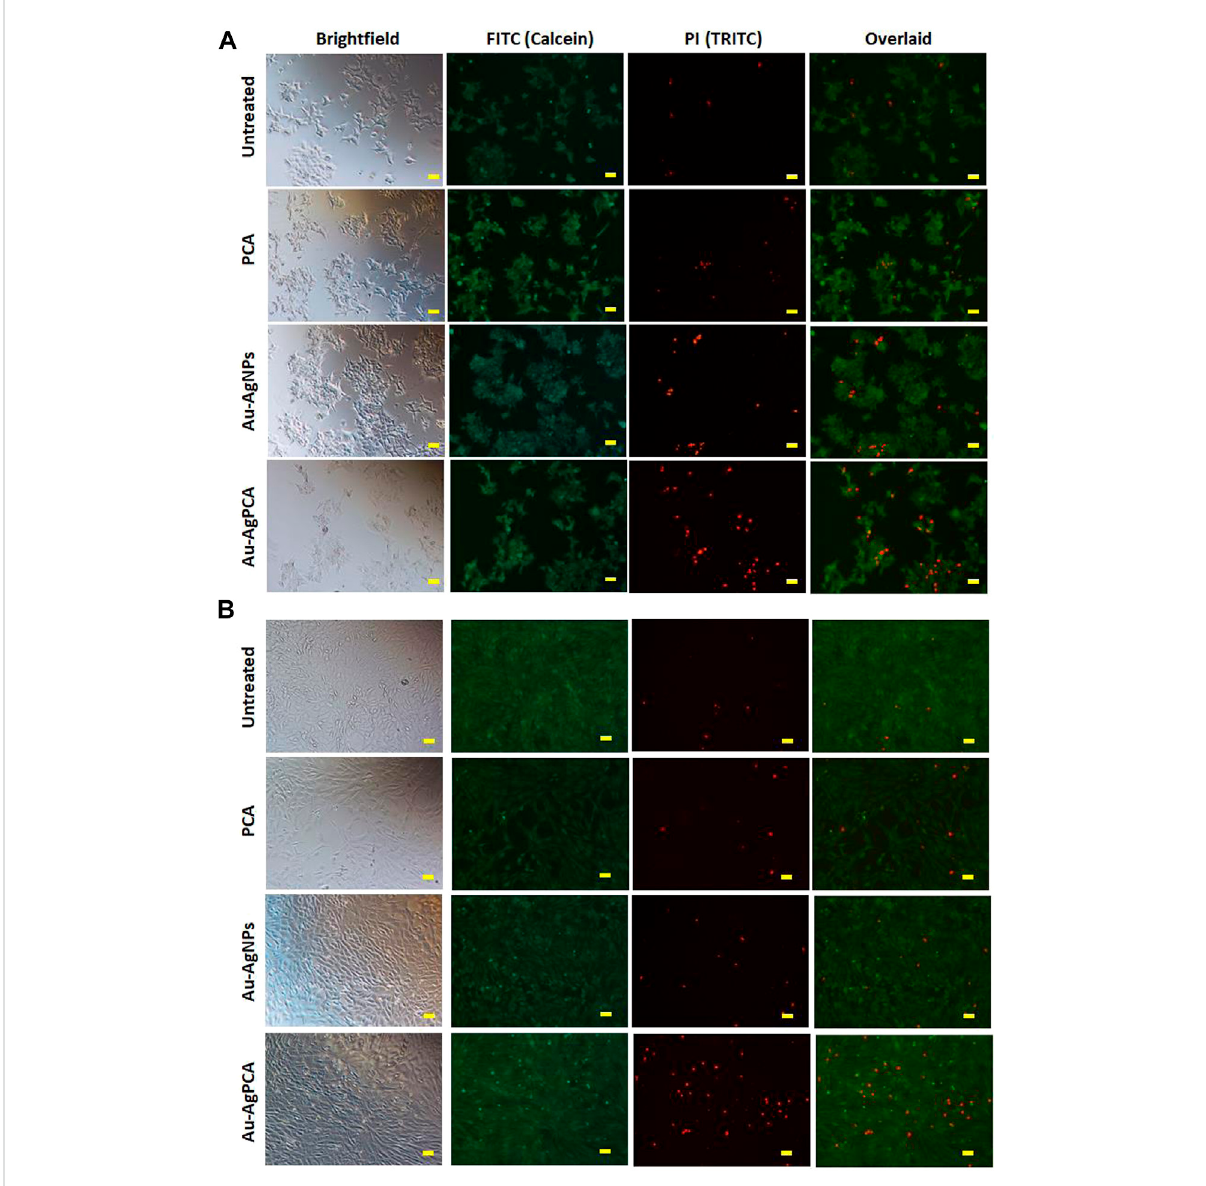
FIGURE 6 Live/dead cells staining. Calcein AM(green: live cells)andpropidiumiodide (red: dead cells)staining of (A) HCT116and (B) CCD112 cells treated with 15 μ g/ml PCA, Au-AgNPs, and Au-AgPCA, respectively. Images were captured at ×10 magni fi cation. Scale bar represents 50